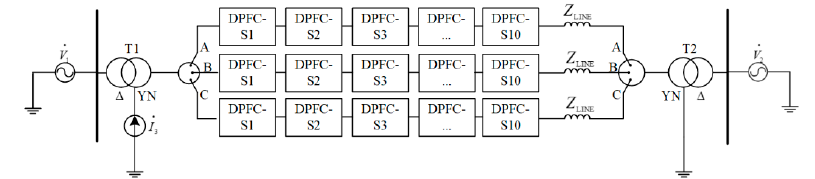
Figure 7. The simulation model of the DPFC.